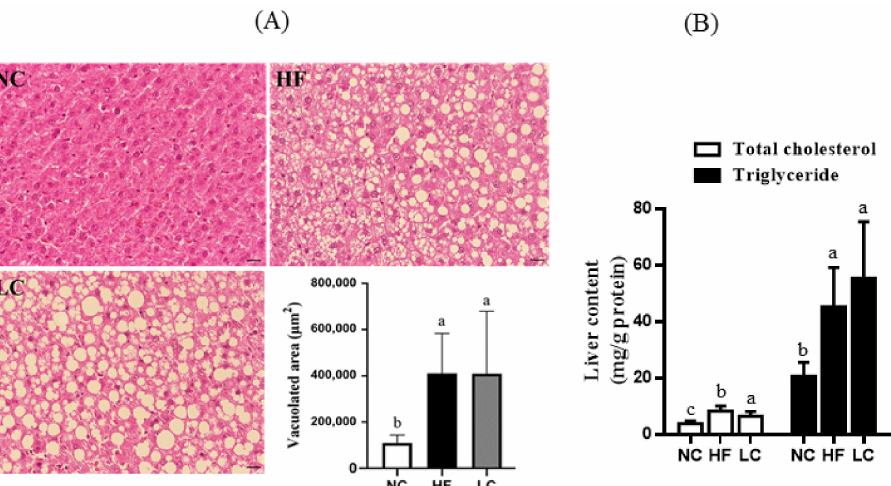
Figure 3. The hepatic morphology and lipid metabolites in rats fed with different experimental diets for 11 weeks. Representative hematoxylin and eosin (HE)-stained images of fat vacuoles in liver tissues are shown and quantified ( A ). The hepatic total cholesterol and triglyceride content are shown in ( B ). Results are expressed as the mean ± SD for each group ( n = 7). Mean values with different letters are significantly different, p < 0.05.